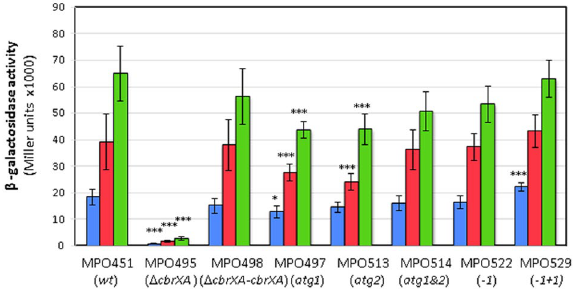
Figure 7. Expression levels of crcZ in a wild type and in strains with different variants of CbrX. β -galactosidase activity was measured for pMPO1316 containing a transcriptional fusion of crcZ to lacZ in MPO451 (wild type), MPO495 ( Δ cbrXA ), MPO498 ( Δ cbrXA-cbrXA ), MPO497 ( Δ cbrXA -ATG1), MPO513 ( Δ cbrXA- ATG2), MPO514 ( Δ cbrXA -ATG1&2), MPO522 ( Δ cbrXA - Δ T) and MPO529 ( Δ cbrXA - Δ T + C). Activity was monitored in LB (blue) and minimal medium supplemented with succinate (red) or oxalacetate (green). Bars represent the averages and standard deviations of at least three independent assays. Stars designate p-values for the Student’s t-test for unpaired samples not assuming equal variance. * :p < 0.05; ** p < 0.01; *** p < 0.005.